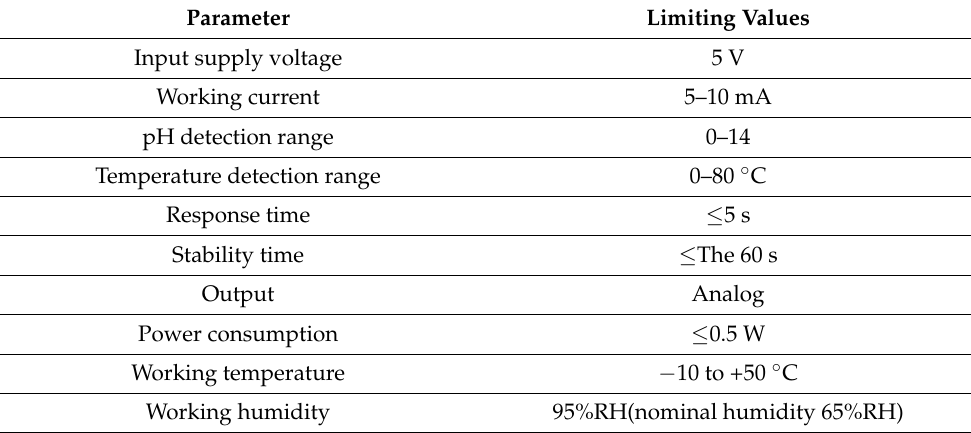
Table 2. Specifications of the pH sensor.